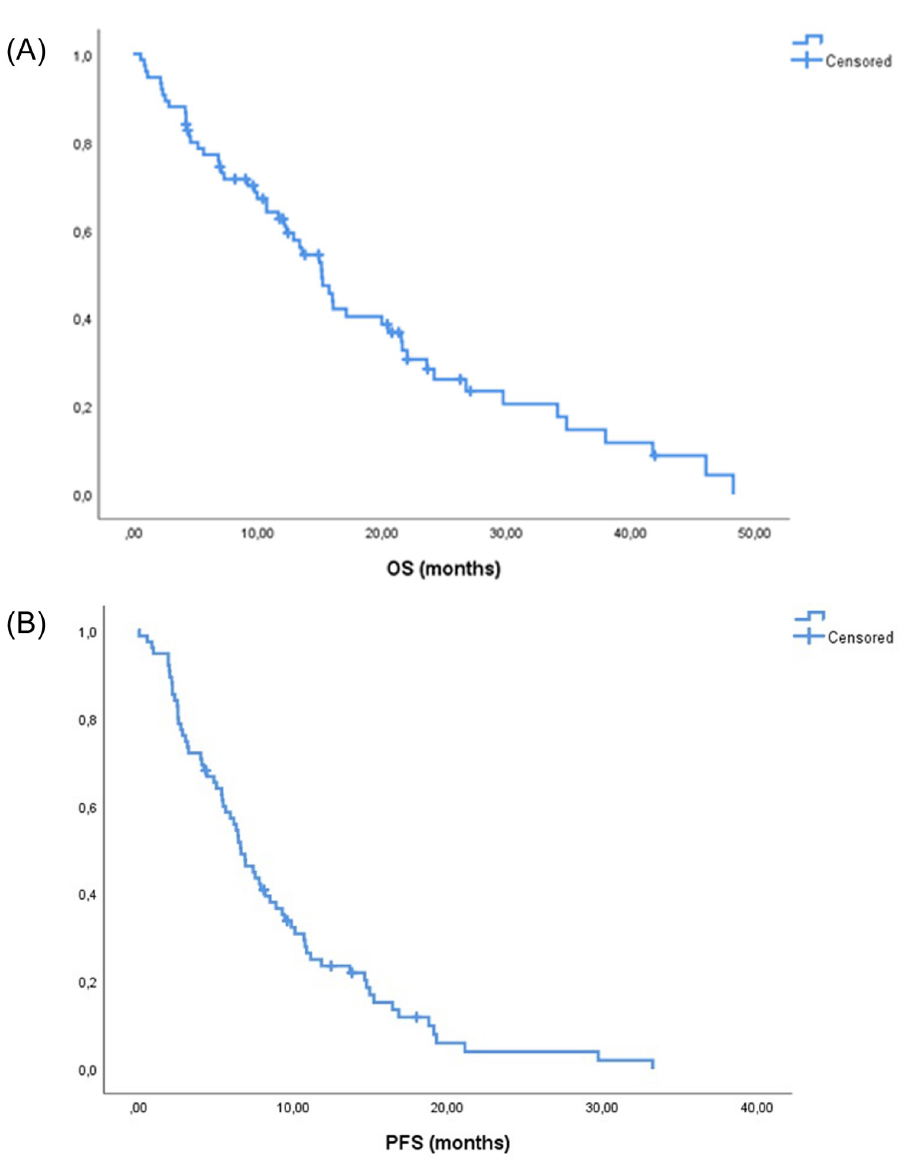
Fig 1. Kaplan-Meier curves for Overall Survival (A) and Progression-Free Survival (B).